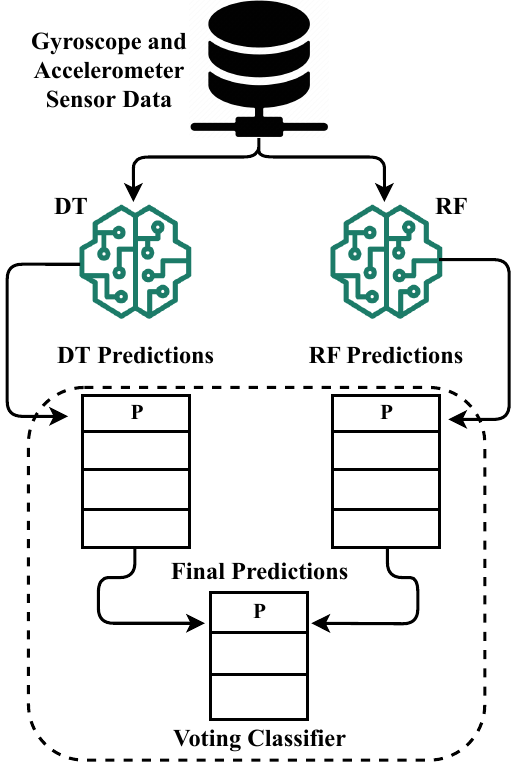
Figure 5. The architectural diagram analysis of our proposed ensemble